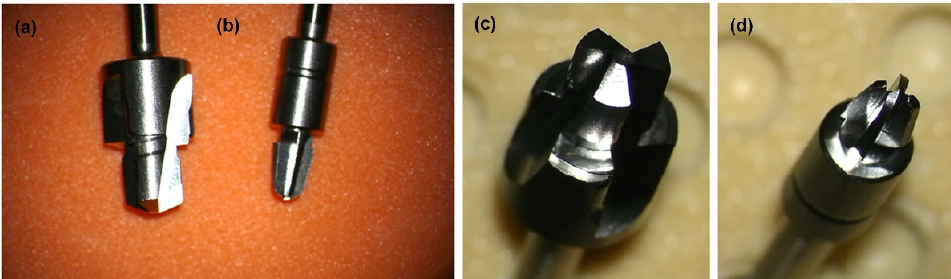
Figure 3. ( a , c ) Widening drill (depth 4 mm and diameter 4.1 mm) with countersink (depth 0.5 mm and diameter 5.5 mm). ( b , d ) Conical guide drill (depth 3 + 4 mm and diameter 3.1 mm), which is described in detail in patent [35]. All drills are made of hardened stainless steel (WS 1.4197). Pictures taken with the Carl ZEISS Vario700 microscope, 6.5× magnification; focal length 225–235 mm.